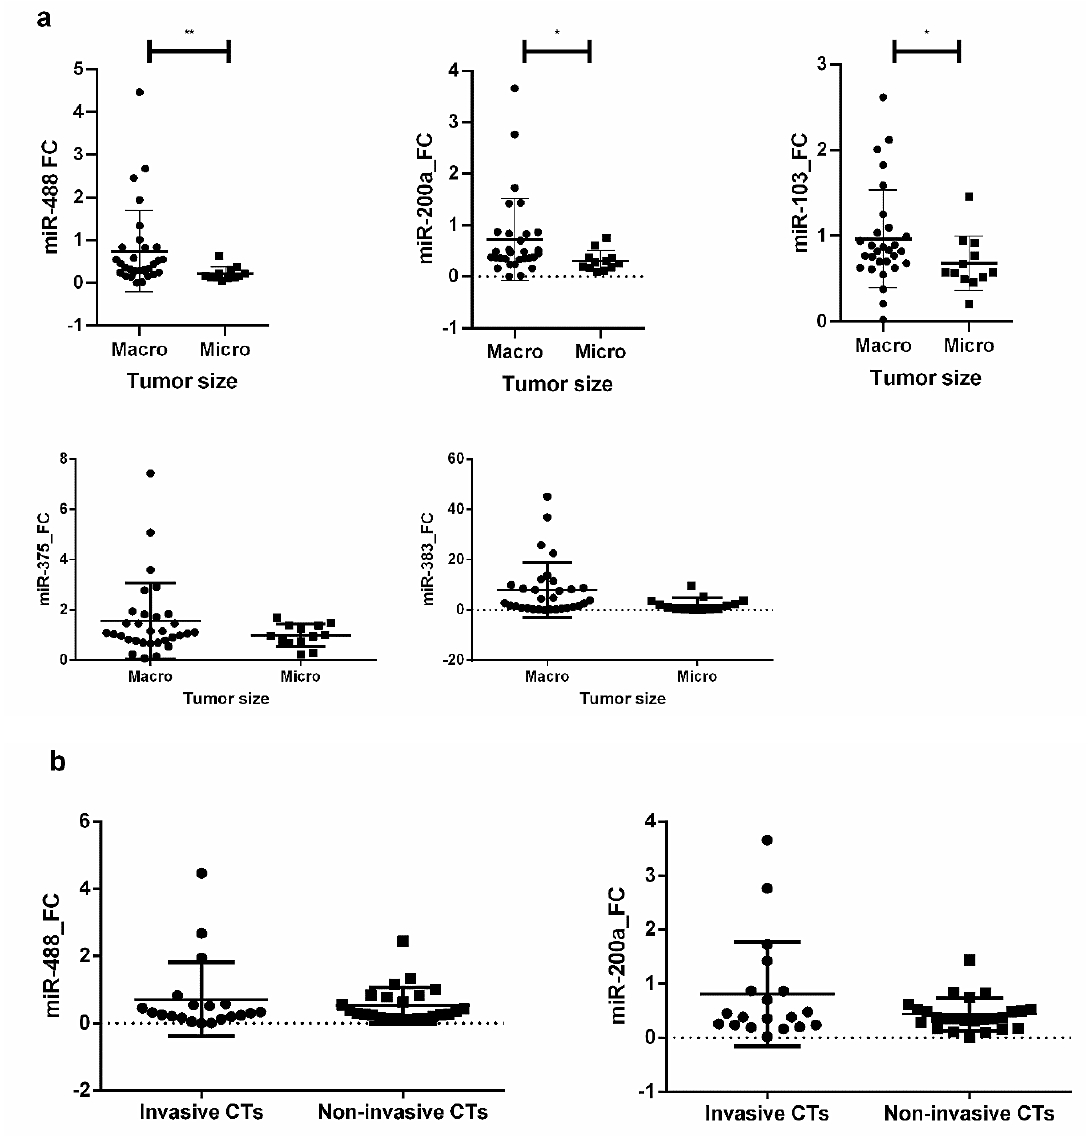
Figure 4. ( a ) Gene expression differences (fold change) of miR-488, miR-200a, miR-103, miR-375, and miR-383 between macro and micro corticotroph tumors; ( b ) gene expression differences of miR-488 and miR-200a between invasive and non-invasive corticotroph tumors. * p < 0.05; ** p < 0.01.